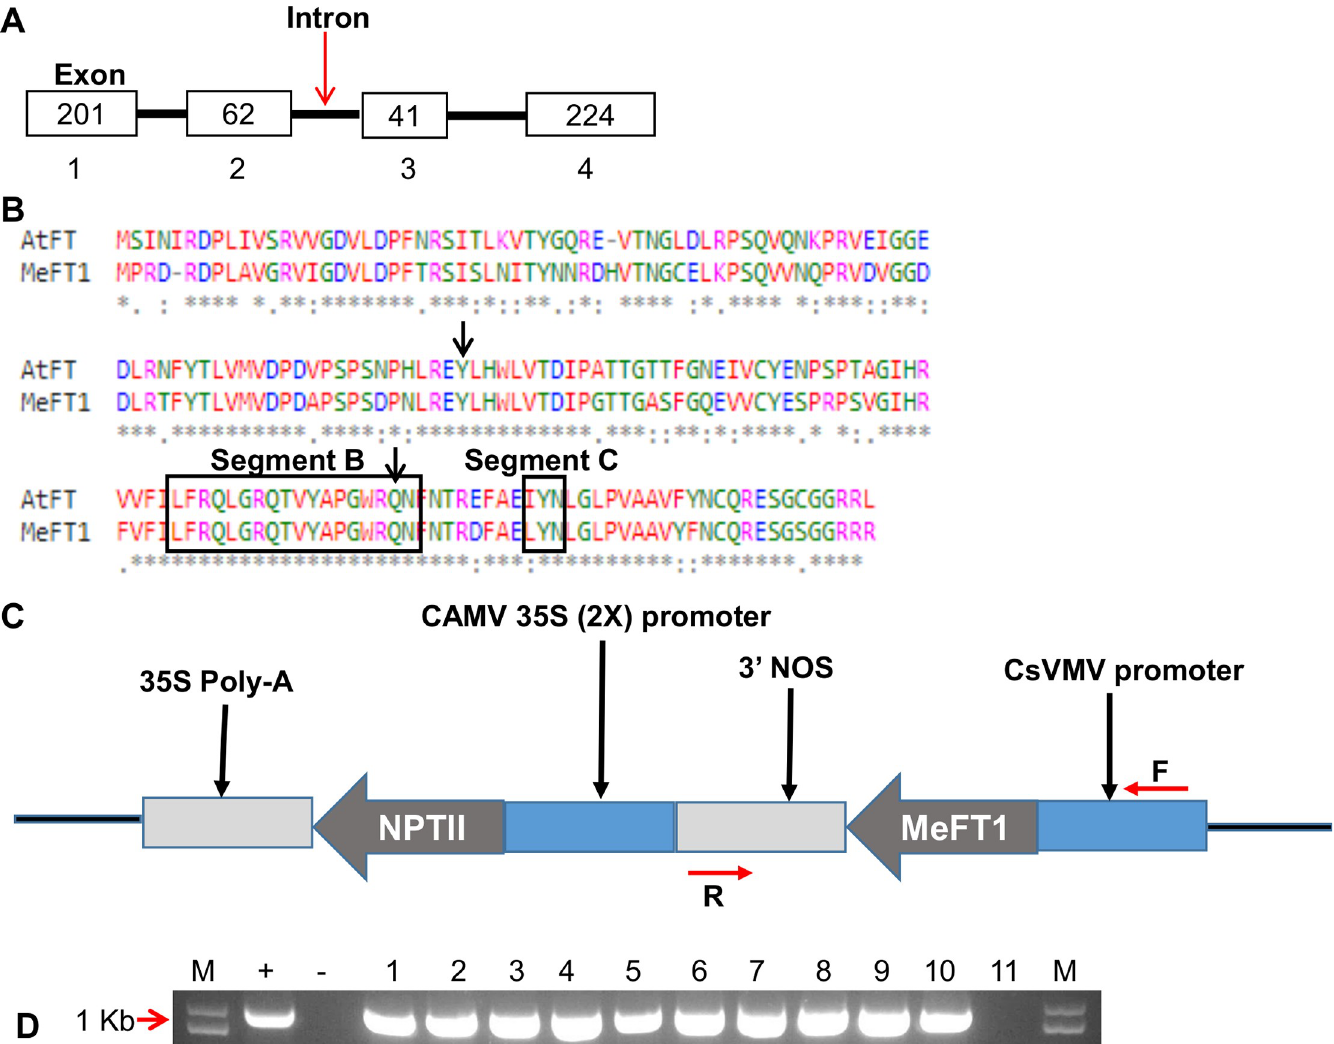
Fig 1. Characterization of MeFT1 gene and detection of putative transgenic plant lines. ( A ) Genomic structure of MeFT1 gene showing exons (box) and introns (line). Numbers in boxes represent size of exon (base pairs) and numbers below the box show exon number. ( B ) MUSCLE alignment of amino acid sequences from Arabidopsis FT and MeFT1 . Boxes represent conserved sequences, black arrows represent critical amino acids that determine functionality of FT gene, Asterisk ( � ) indicates identical amino acids. ( C) Linear vector map showing T-DNA used to overexpress MeFT1 in transgenic cassava plants with MeFT1 fused to the CsVMV promoter and NOS terminator. Neomycin phosphotransferase II (NPTII) confers paramomycin resistance for selection of transgenic cassava plants, F and R indicate forward and reverse primers used for PCR detection of the T-DNA cassette in transgenic plants). ( D ) Gel electrophoresis showing PCR detection of 1 kb fragment on 1.2% agarose gel. M is a size Marker, + plasmid pUC57 positive control,—negative water control, lanes 1–10 are putative transgenic plant lines, 11 and is a non- transgenic plant regenerated from somatic embryo.